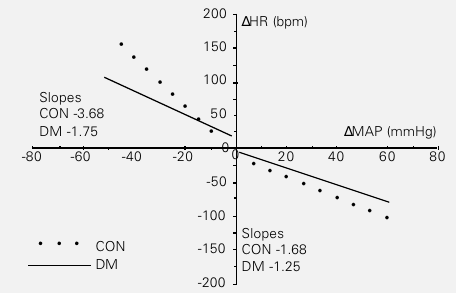
Figure 1 - STZ-diabetic rats pre- sented an impairment of bradycardic (lower right) and tachycardic (upper left) response to AP changes induced by in- creasing doses of phenylephrine and sodium nitroprusside. The slope of the lines obtained by linear regression analysis was -1.68 vs -1.25 bpm/mmHg (P = 0.019) for control (CON) and dia- betic rats (DM), respectively, af- ter an increase in AP. The slope of the lines obtained by linear regression analysis was -3.68 vs -1.75 bpm/mmHg (P = 0.004) for control and diabetic rats, respec- tively, after a decrease in AP (un- paired Student t